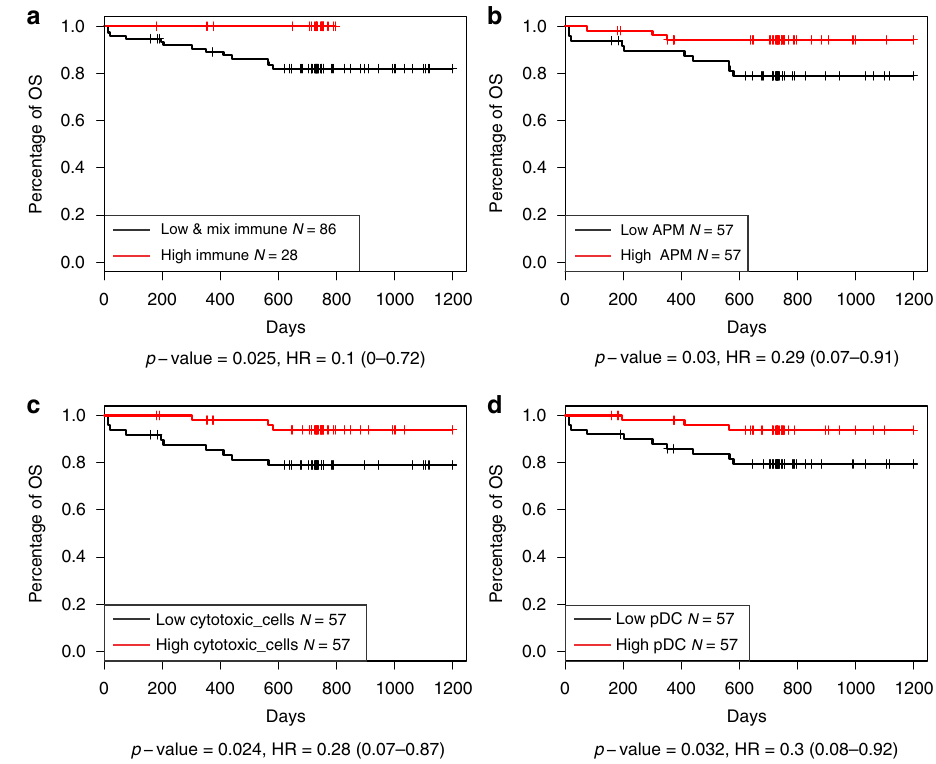
Fig. 7 Immune signatures associated with SQCC patient overall. a Immune signature, immune MIX and LOW groups were combined together and compared with the immune HIGH group. b APM signature. c Cytotoxic cell signature. d pDC signature. Source data are provided as a Source Data fi